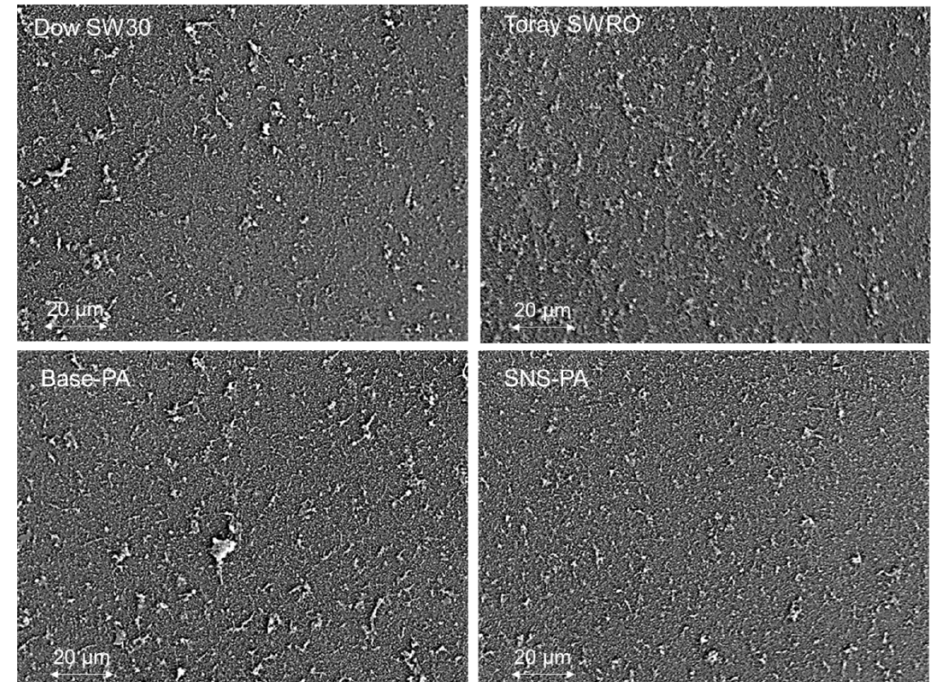
Figure A2. SEM top-view images of SNS-PA, Dow SW30, Toray SWRO, and base-PA membranes after 24 h gypsum scaling tests, followed by 30 min D.I. water flushing. (Scaling test conditions: 24 h filtration with gypsum feed solution (pH of 5.7) and a membrane surface saturation index of gypsum SI g,m = 1.3).